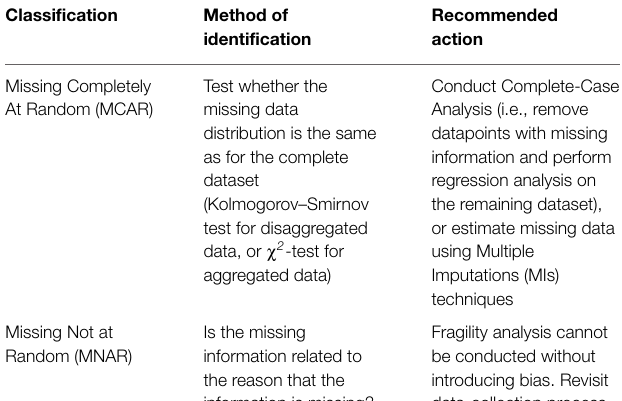
TABLE 11 | Classification and treatment of missing data (adapted from Macabuag et al., 2016a).